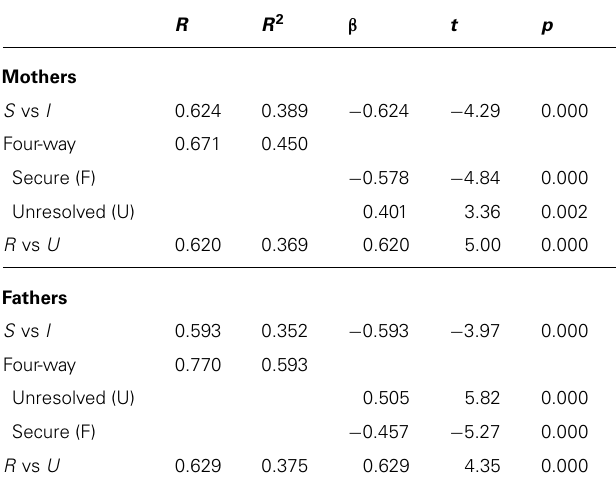
Table 4 | Linear multivariate regression for mothers and fathers attachment patterns on child’s